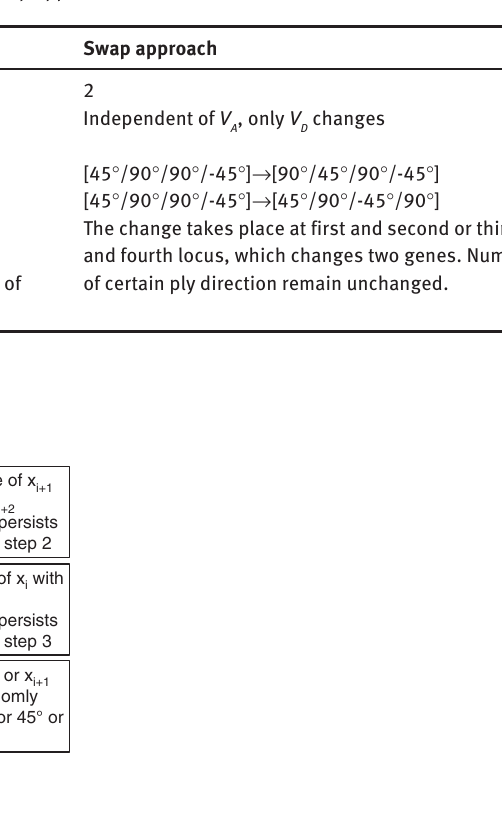
Table 2 Comprehensive comparison between replacement approach and swap approach.